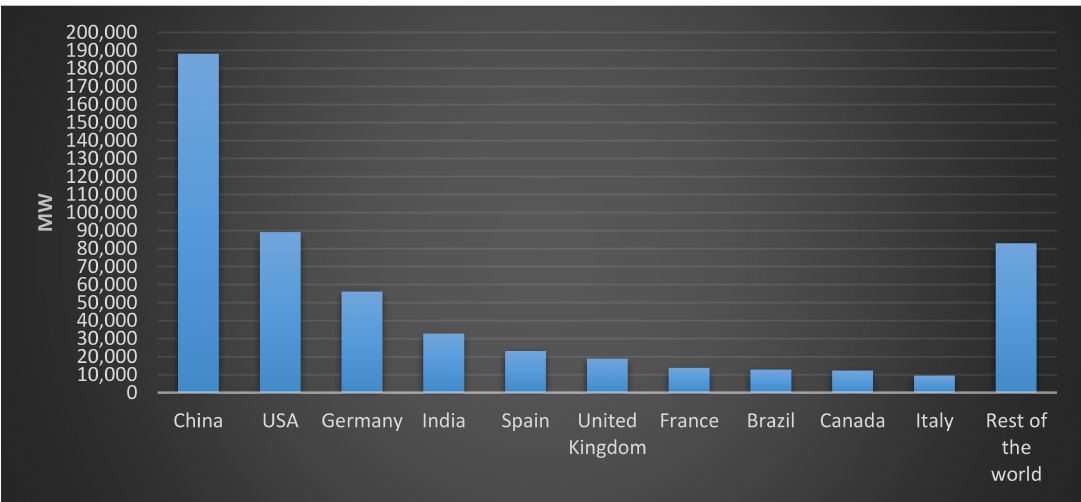
Figure 3. Global wind power capacity in MW